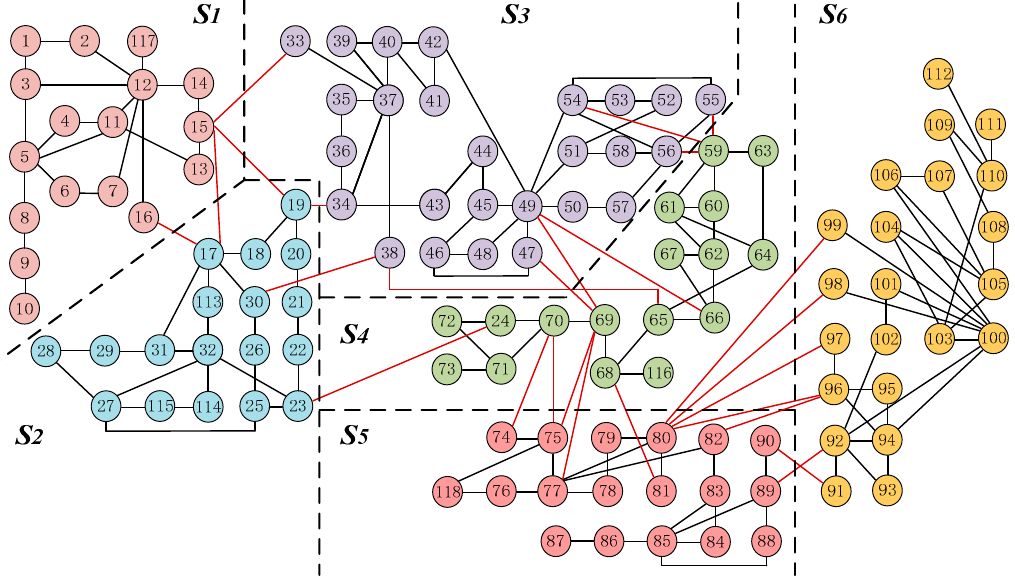
Figure 6. Partition areas of the IEEE 118-bus system.